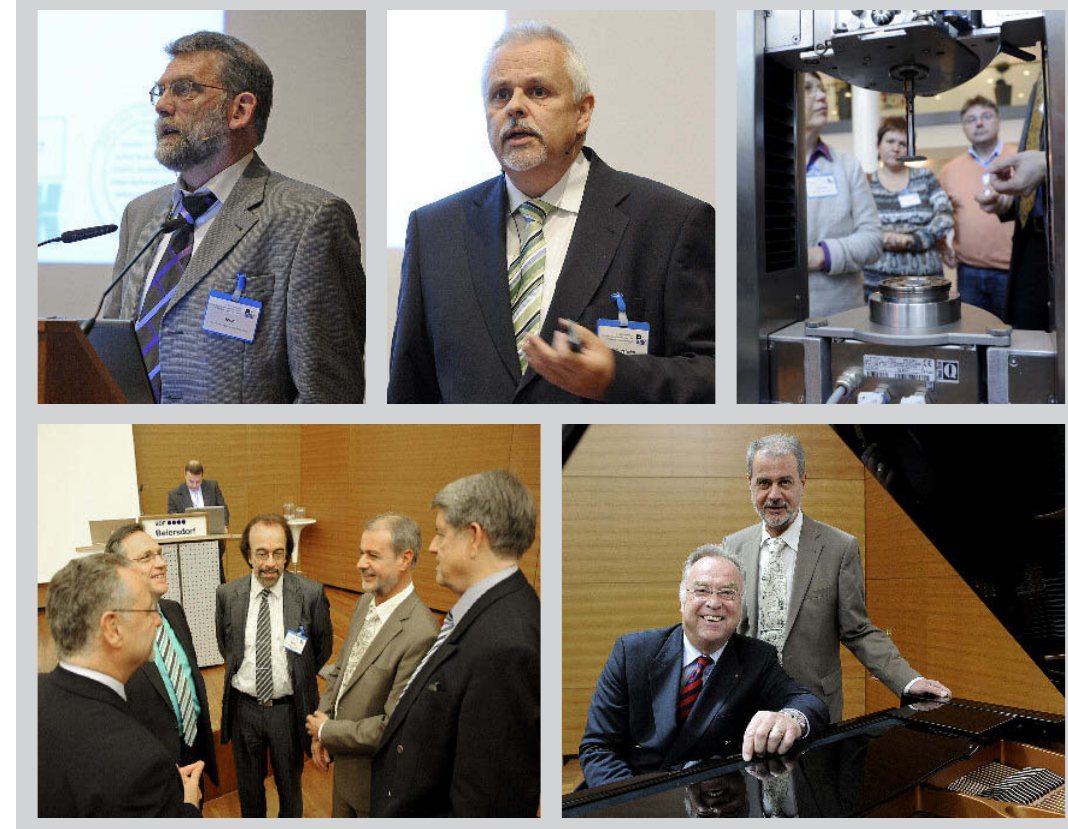
Figure 6 (left above): Lothar Gehm. Figure 7 (middle above): Anton Wittersheim. Figure 8 (right above): Technical discussions. Figure 9 (left below): Prof. Wittern, Dr. Schmidt- Lewerkühne, Prof. Windhab, R. Brummer, Prof. Kulicke. Figure 10 (right below): Prof. Böttger and R.